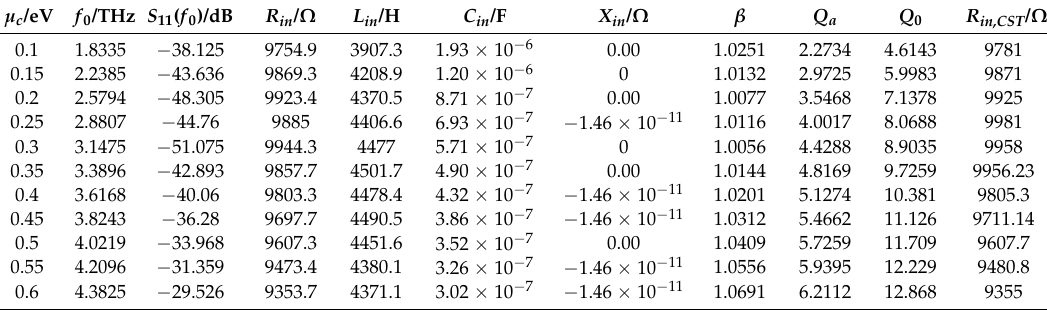
Table 1. The simulated data with chemical potential ranging from 0.1 eV to 0.6 eV. The relaxation time is set as 0.5 ps, the arm length is 5 µm, the thickness of the substrate is 90 nm. μ c /eV